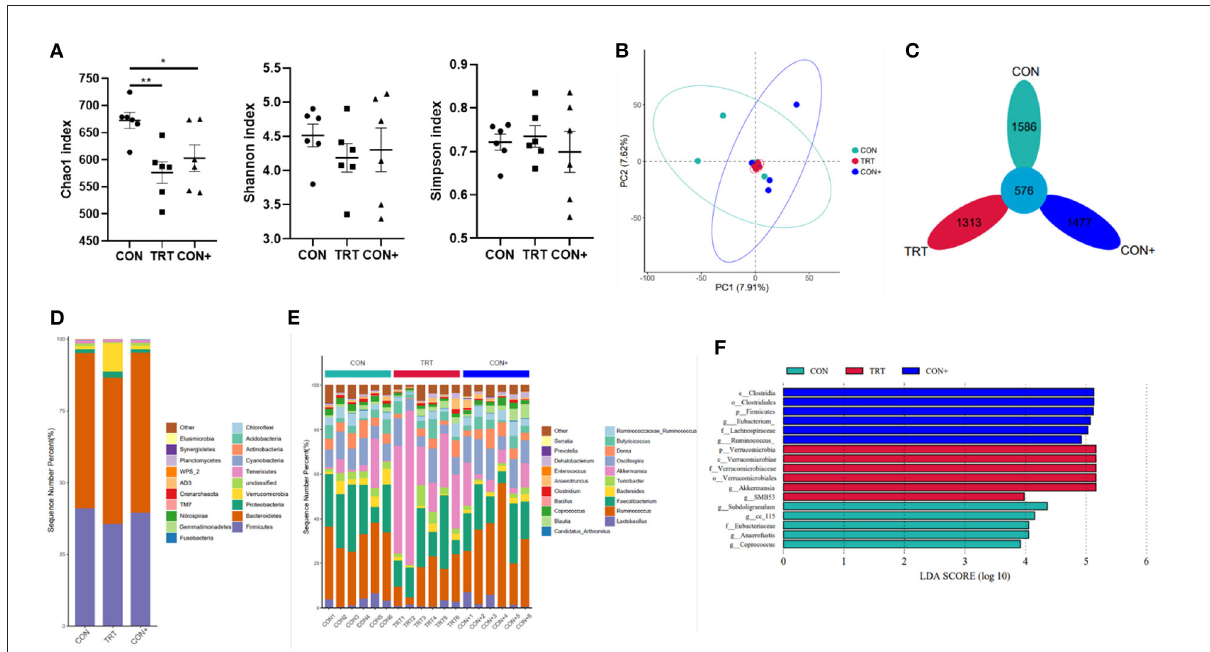
FIGURE4 Effects of B. subtilis M6 microbial composition of caecum. (A) The α -diversity comparisons was analyzed by Chao1, Shannon’s diversity and Simpson index, data was shown as mean ± SEM. (B) The β -diversity comparisons was analyzed by PCA. (C) Common species analysis was shown by Petal diagram. (D) Community composition of the gut microbiota at the phylum levels. (E) Community composition of the gut microbiota at the genus levels. (F) Bacterial taxa differentially was identified by LEFSe using an LDA score threshold of > 2.0 and P < 0.05. n = 6. * P < 0.05; ** P <